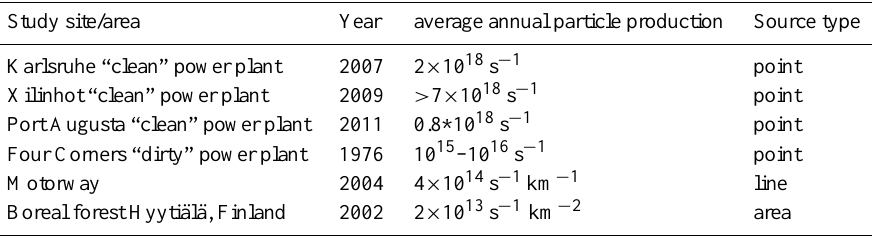
Table 2. Comparison of ultrafine particle production